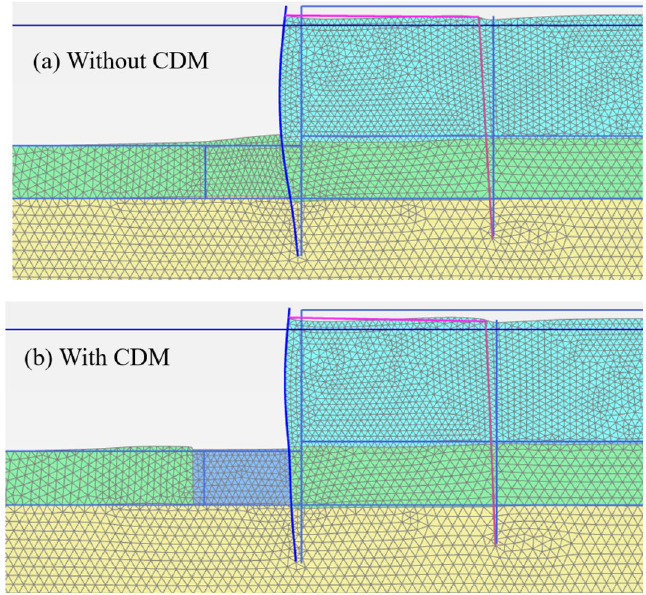
Fig. 5 Overall deformed shape of the quay walls after earthquake (the Coalinga